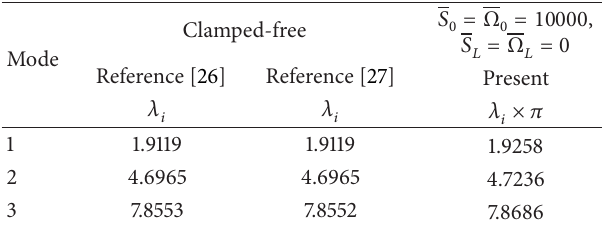
Table 2: Verification of the proposed method for a beam with clamped-free